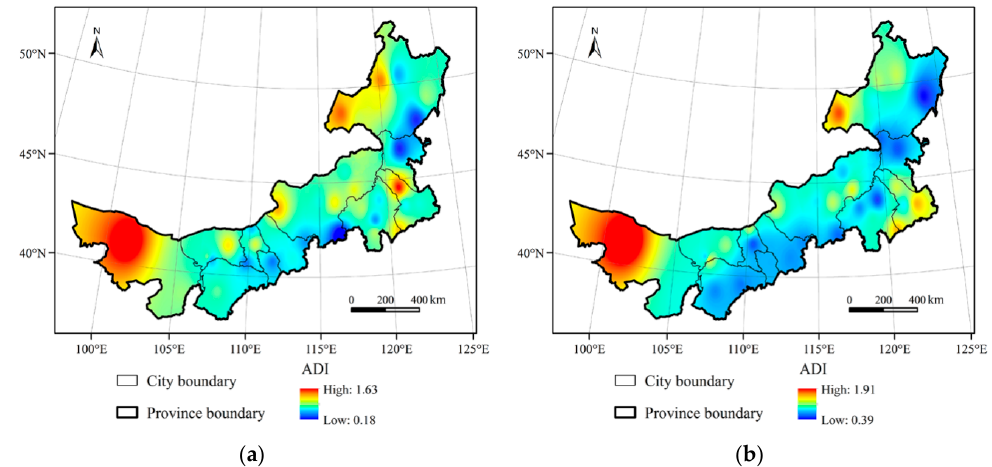
Figure 4. The spatial distribution of area drought intensity (ADI) values in (a) annual and (b) plant growth period.